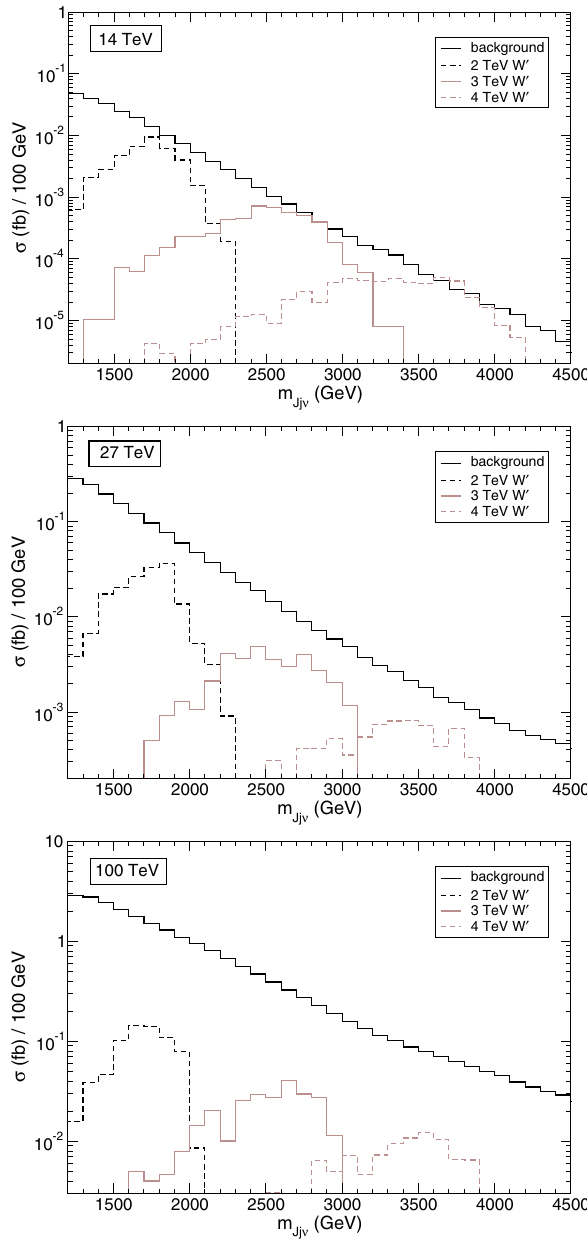
Fig. 10 Signal and background cross sections as a function of the invariant mass m Jj ν for the W (cid:2) signals and the SM background, in the 2 b sample with z 1 ≥ 0 .